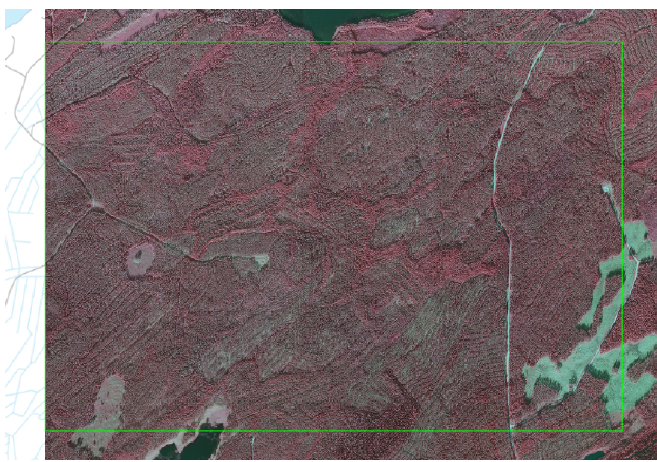
Figure 2. Projected land area showing the location covered.